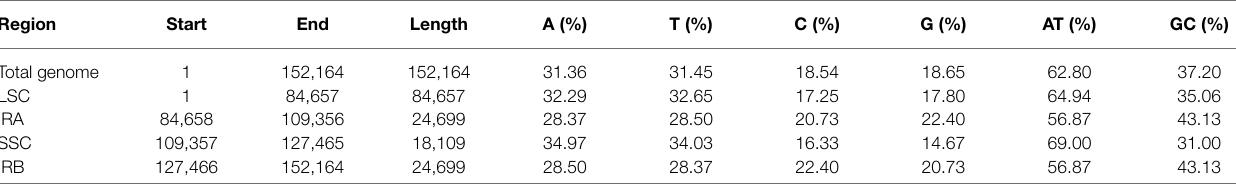
TABLE 2 | Chloroplast structure statistics of Erigeron breviscapus